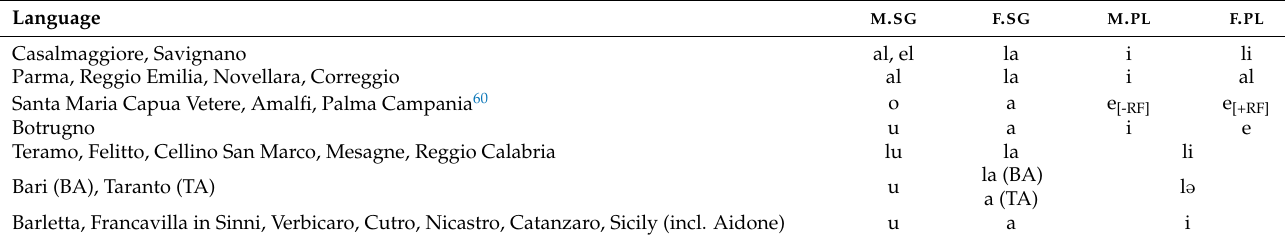
Table 1. Number and gender distinctions on definite